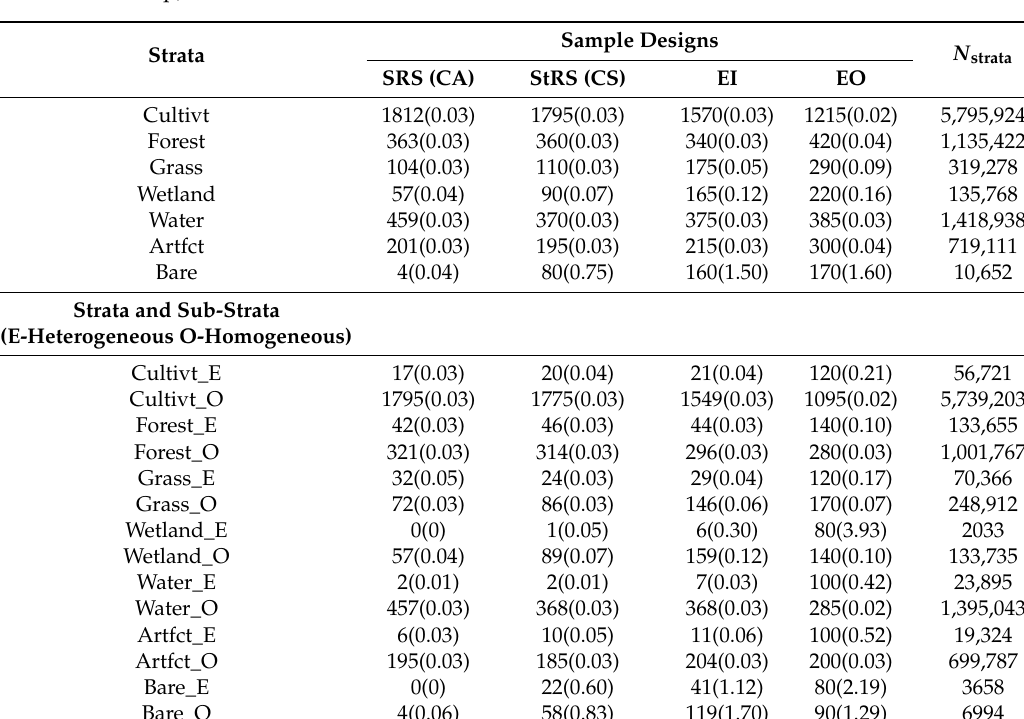
Table 3. Sample allocations for different sampling designs (number of sample pixels belonging to individual strata or sub-strata, while sampling intensities (in percentages) shown in parentheses are with respect to the total number of pixels ( N strata ) belonging to specific strata or sub-strata in the land-cover